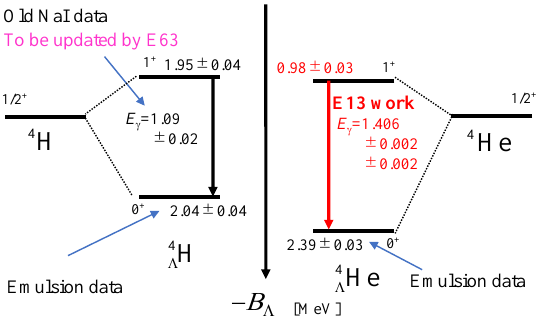
Figure 2. Level schemes of the A = 4 mirror hypernuclei. The binding energies of both ground states are determined by old emulsion data [1]. The 4 (cid:3) H(1 + ! 0 + ) transition energy is the average value of three independent experiments measured by NaI